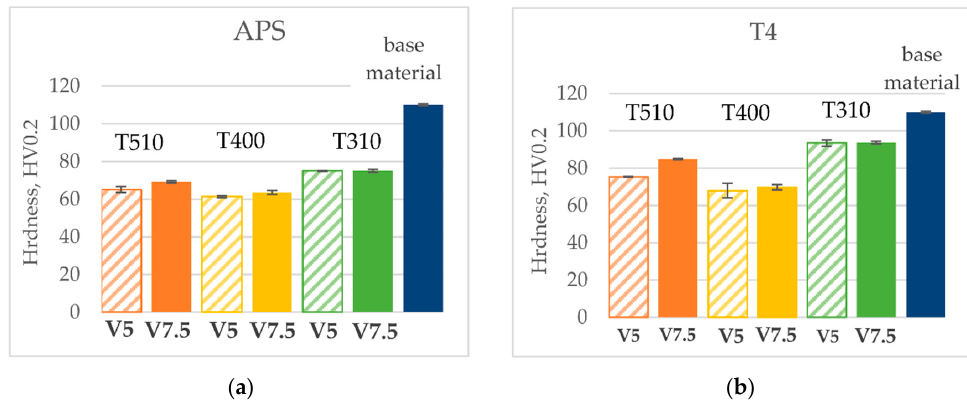
Figure 18. ( a ) Hardness mean values and standard deviations recorded at specimen centre in APS state for different treatment speed and peak temperature; ( b ) Hardness mean values and standard deviations recorded at specimen in T4 state for different treatment speed and peak temperature. It is observed that as the treatment speed decreases, the hardness value slightly de- creases for all investigated peak temperatures. However, the effect of treatment speed on softening is more evident at the highest tested peak temperatures, especially in the T4 state. This behaviour is explained by the greater dissolution of the precipitates that were initially present in the alloy. At the moment at which micro-hardness measurements were performed, the softening obtained in the T4 state is constantly lower than that measured in the APS state, confirming the precipitation of Mg and Si atoms solubilized during the thermal cycle imposed by the physical simulation. Finally, a marked influence of peak temperature is observed, with the greatest reduction in hardness occurring at the peak temperature of about 400 °C, especially in the T4 state. Based on the temperature profiles estimated with the thermoelectric FE model, the effect of the peak temperature on soften- ing can be investigated by analyzing the micro-hardness profiles. Figure 19 shows, for example, micro-hardness profiles measured in tapered specimens in the T4 state for all explored treatment speeds and peak temperatures (Figure 8). Figure 19a compares the hardness profiles relating to treatment with a speed of 5 mm/s, while Figure 19b compares those corresponding to a treatment speed of 7.5 mm/s.